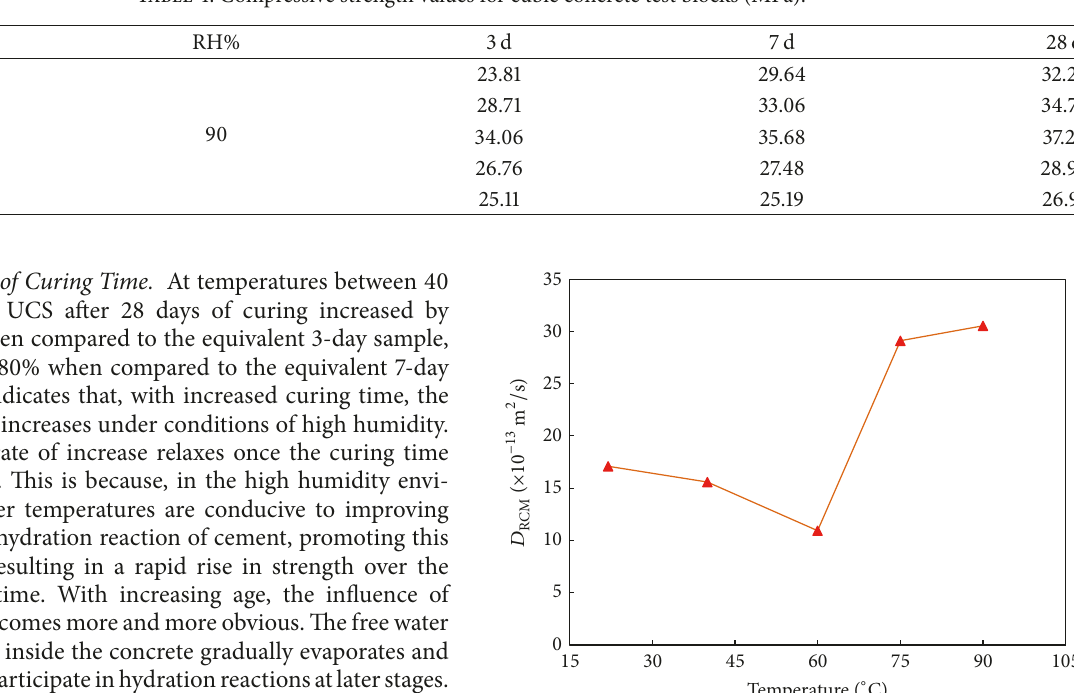
Figure 4: Chloride ion penetration test. Table 4: Compressive strength values for cubic concrete test blocks (MPa).